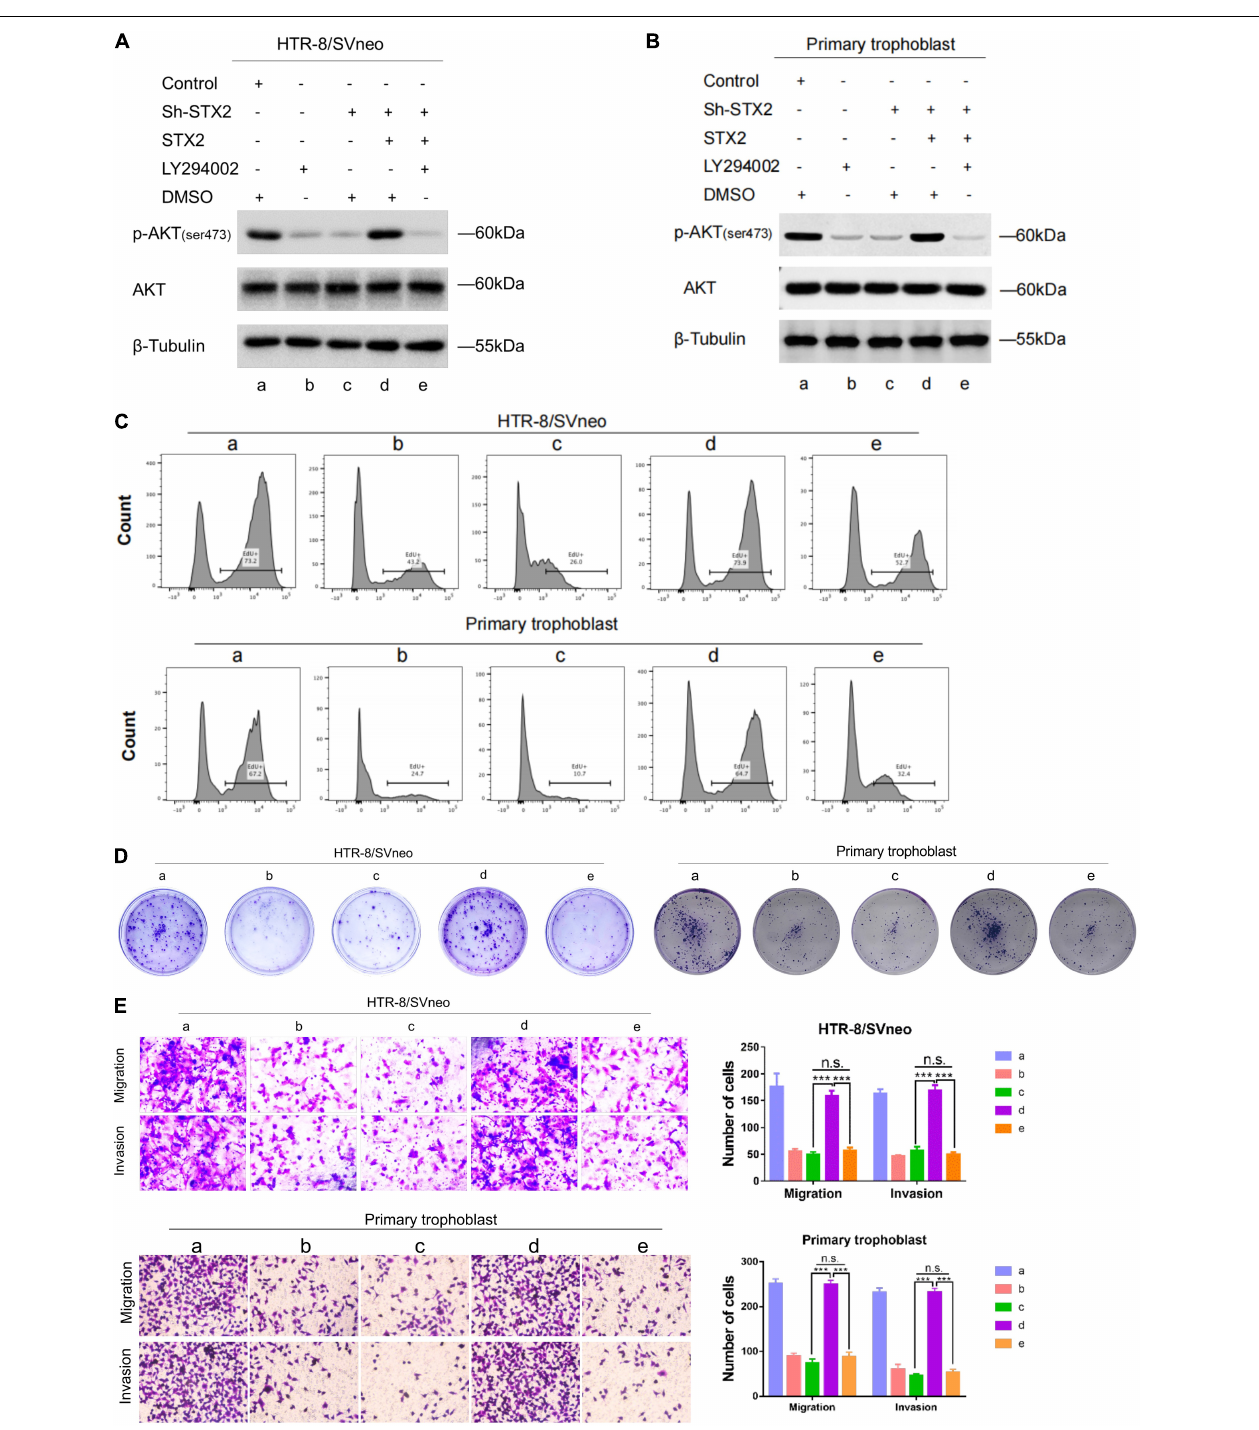
FIGURE 4 | STX2 promotes trophoblasts proliferation, migration and invasion through activating PI3K-AKT pathway. (A,B) Western blot analysis of p-AKT (ser473), AKT in indicated stably transfected HTR-8/SVneo and primary human trophoblast cells treated with LY294002 (PI3K inhibitor, 10 µ M) or DMSO (negative control) for 48 h. (C) EdU assay and (D) colony forming assay were used to evaluated the proliferation of control and experimental cells in which STX2 was stably transfected with or without LY294002 treatment. (E) Transwell assays were used to evaluated the migration and invasion of control and experimental cells in which STX2 was stably transfected with or without LY294002 treatment. All the experiments were repeated three times independently. Data are represented as the mean ± SEM. Student’s t -test: *** P < 0.01.